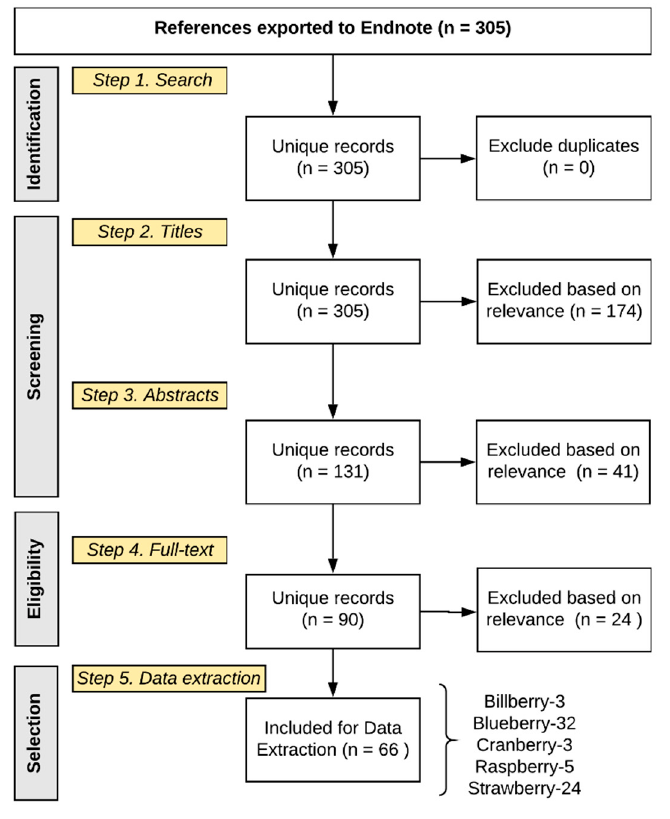
Figure 1. Summary of selected studies.